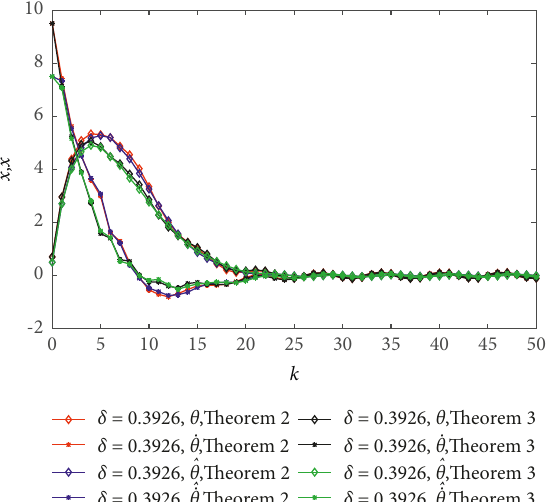
Figure 8: State and estimated state with δ � 0 . 3936.